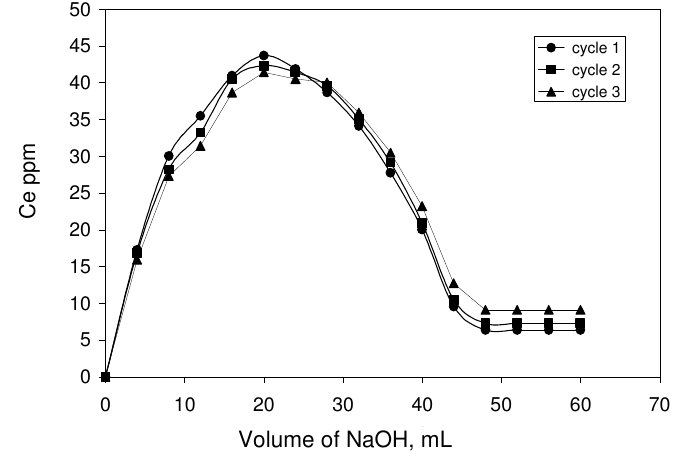
Figure 11 . Desorption curves of Cr(VI) from trametes versicolor polyporous